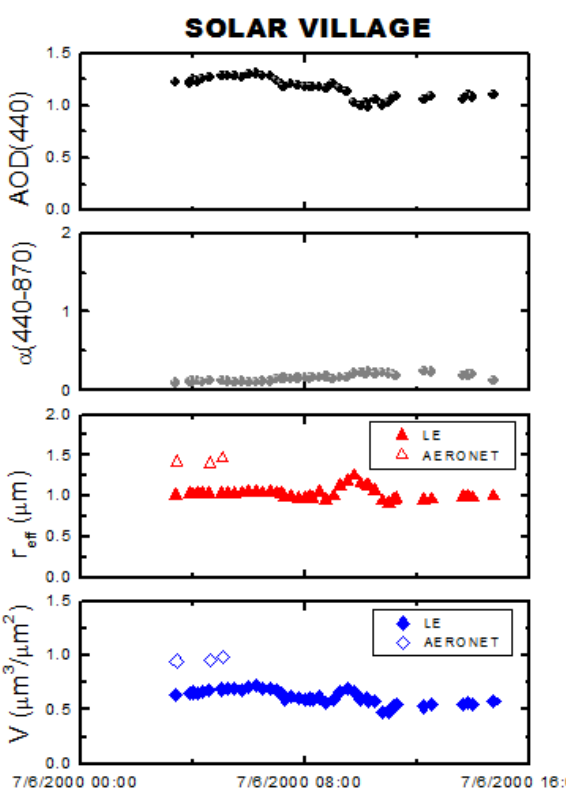
Figure 7. Time evolutions of aerosol optical depth (AOD(440)) and Ångström parameter ( α (440–870)) from AERONET Level 2.0 data at FORTH Crete on 26 July 2004. Also effective radius ( r eff ) and columnar volume aerosol content ( V ) are shown, both for opera- tional AERONET (open symbols) and linear estimation (full sym- bols)